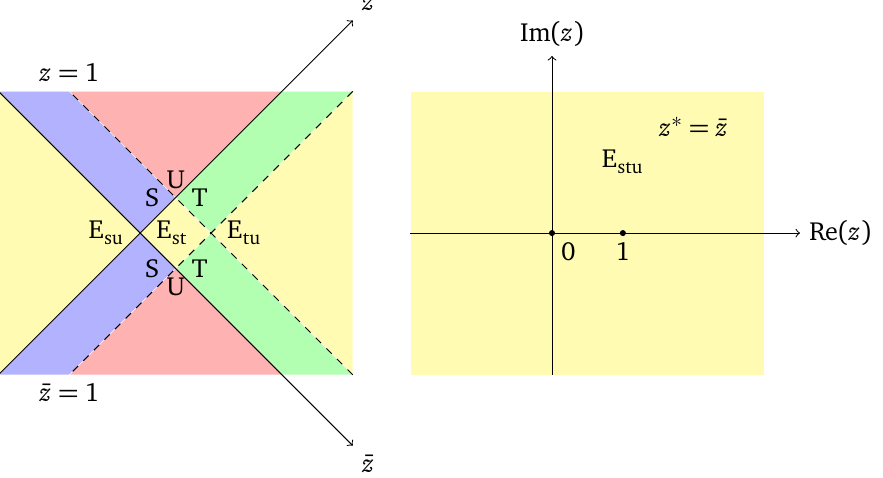
Figure 5.1: The corresponding range of ( z , ¯ z ) pair of each class /